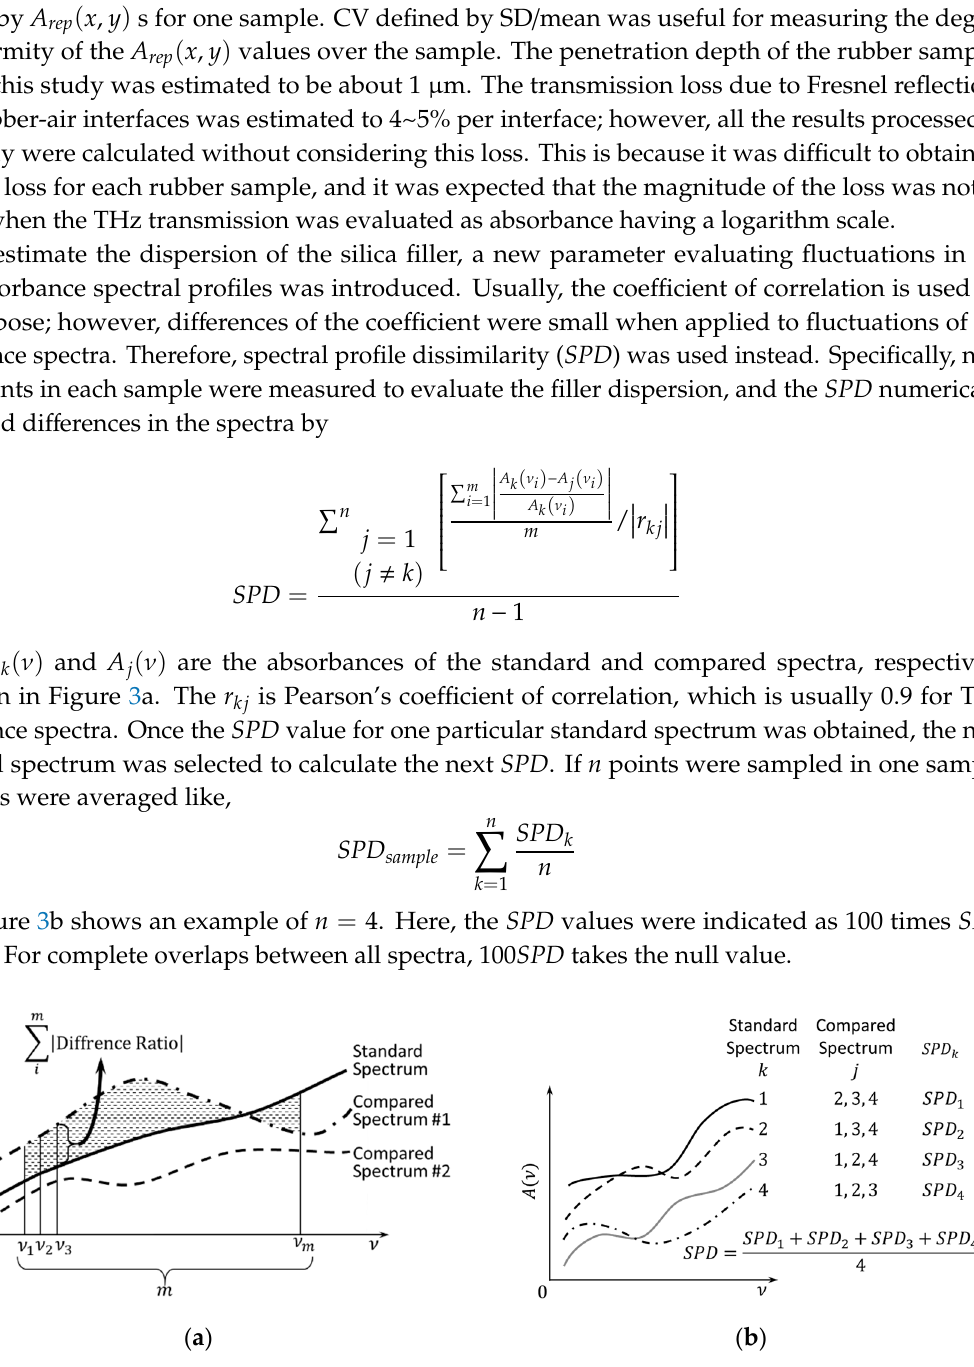
Figure 3. Definition of spectral profile dissimilarity (SPD). ( a ) SPD calculation, and ( b ) averaged SPD in one sample.